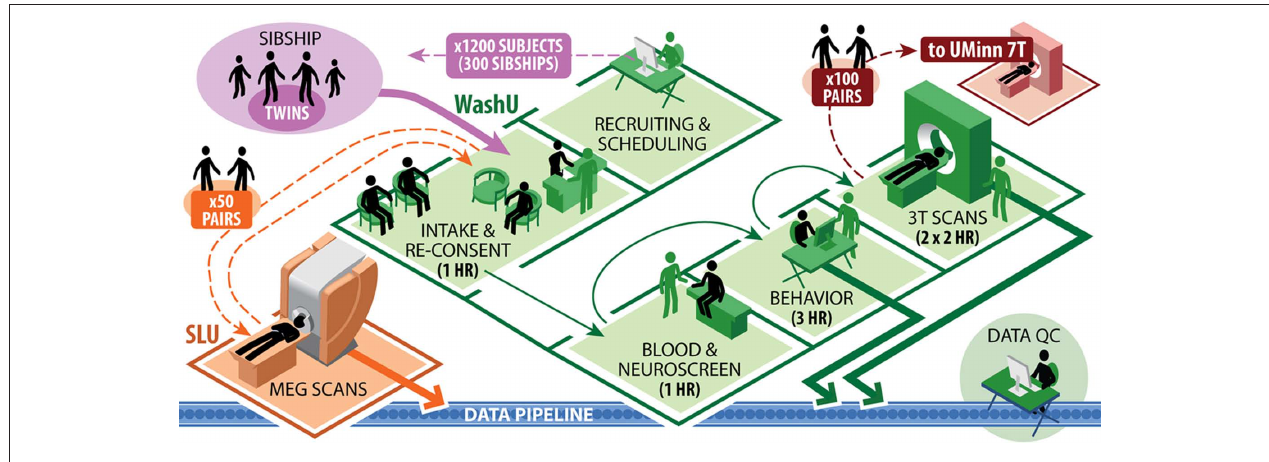
FIguRe 1 | HCP subject